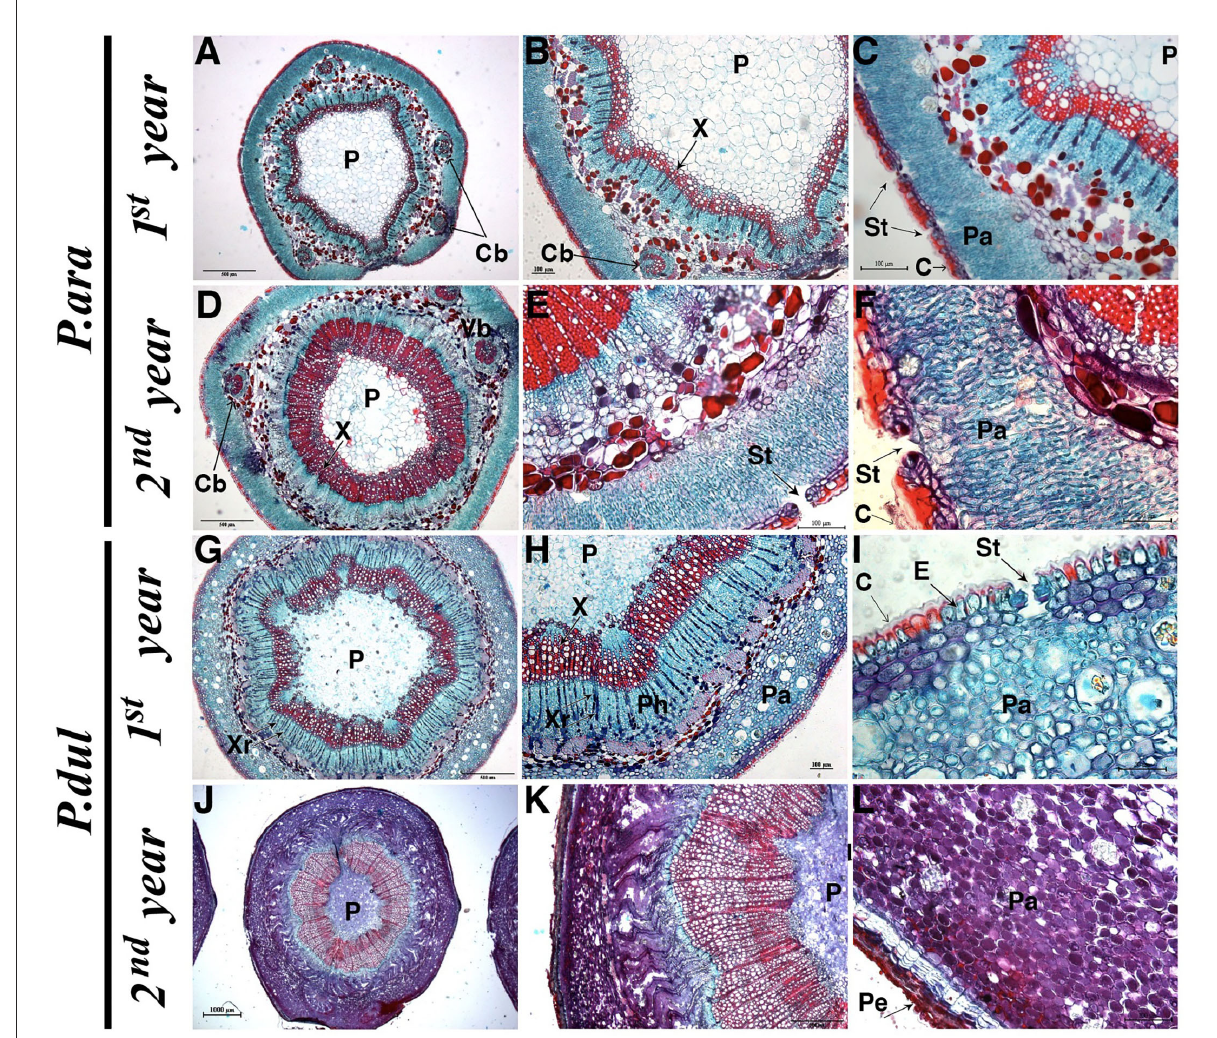
FIGURE4 Histological analysis of cross sections in young and mature (1 st and 2 nd -year) stems of P. arabica and P. dulcis. Safranin-O/fast green stain. Letters on cuts indicate: C, Cuticula; Cb, Cortical bundles; E, Epidermis; P, Pith; Pa, Parenchyma; Pe, Periderm; Ph, Phloem; St, Stomata; X, Xylem; Xr, Xylem ray. Sizes for scale bars: (A,D,G,K) 500 uM; (B,C,E,H,L) 100 uM; (F,I) 50 uM; (J) 1,000